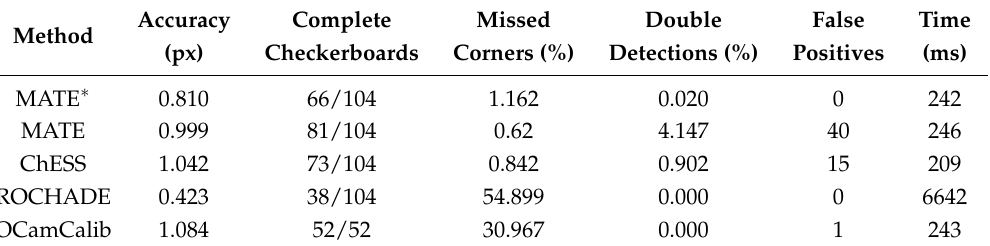
Table 2. Results on the training set P full .